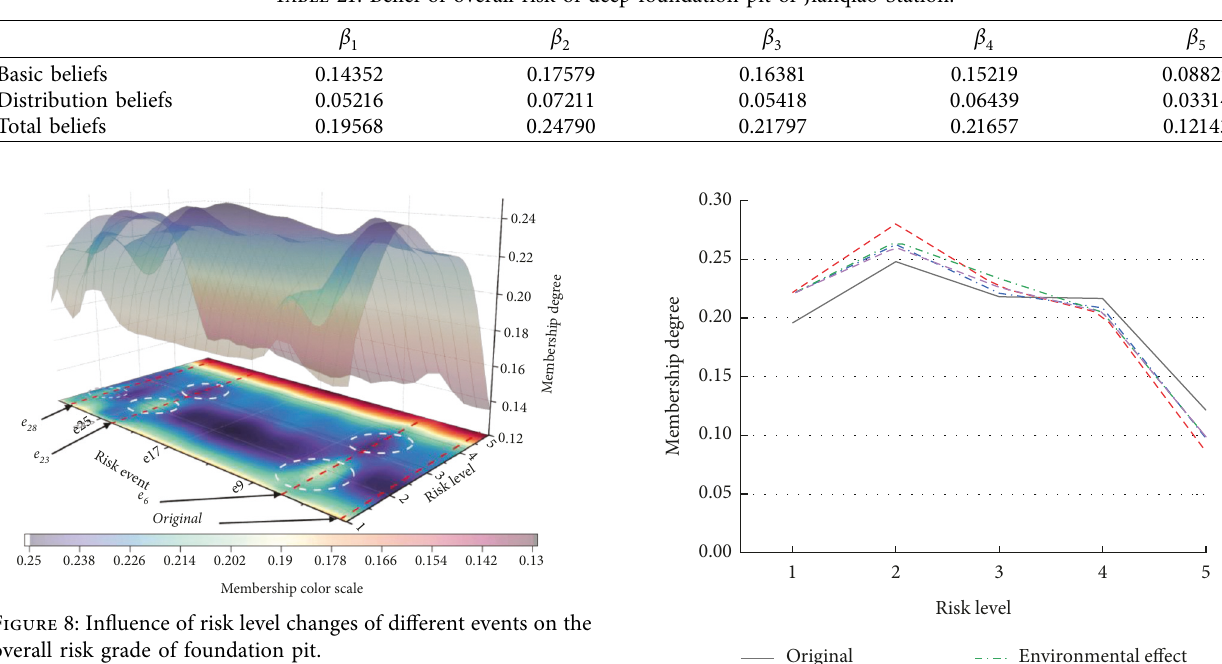
Table 21: Belief of overall risk of deep foundation pit of Jianqiao